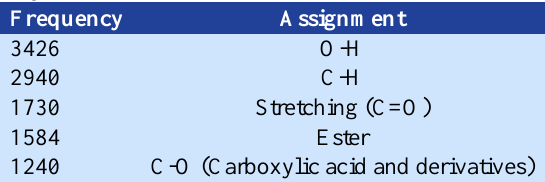
Figure 3. Fourier Transform Infrared Spectroscopy of gum tragacanth (B1) and grafted gum tragacanth (B2)